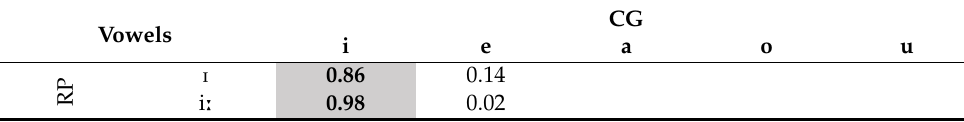
Table 4. Results of the classification test. Dark gray cells represent the L1 responses with the highest probability. Bold values indicate above chance